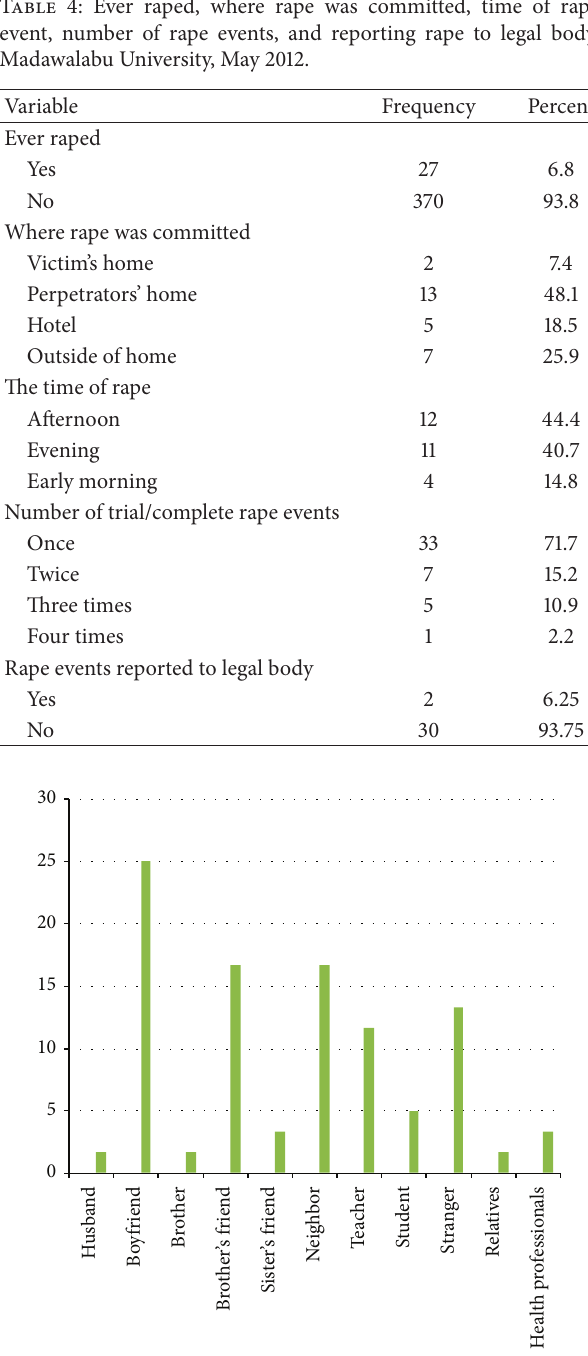
Figure 1: Percentage distribution of perpetrators of rape, Madawal- abu University, May 2012.